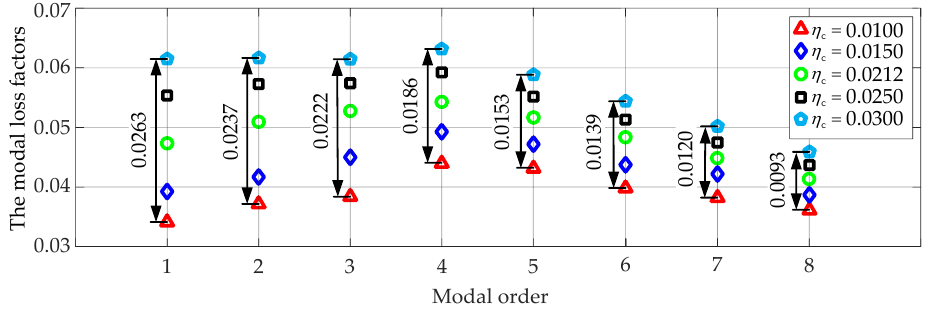
Figure 6. The variation rate of resonant response of the composite shell corresponding to different loss factors of hard coating.